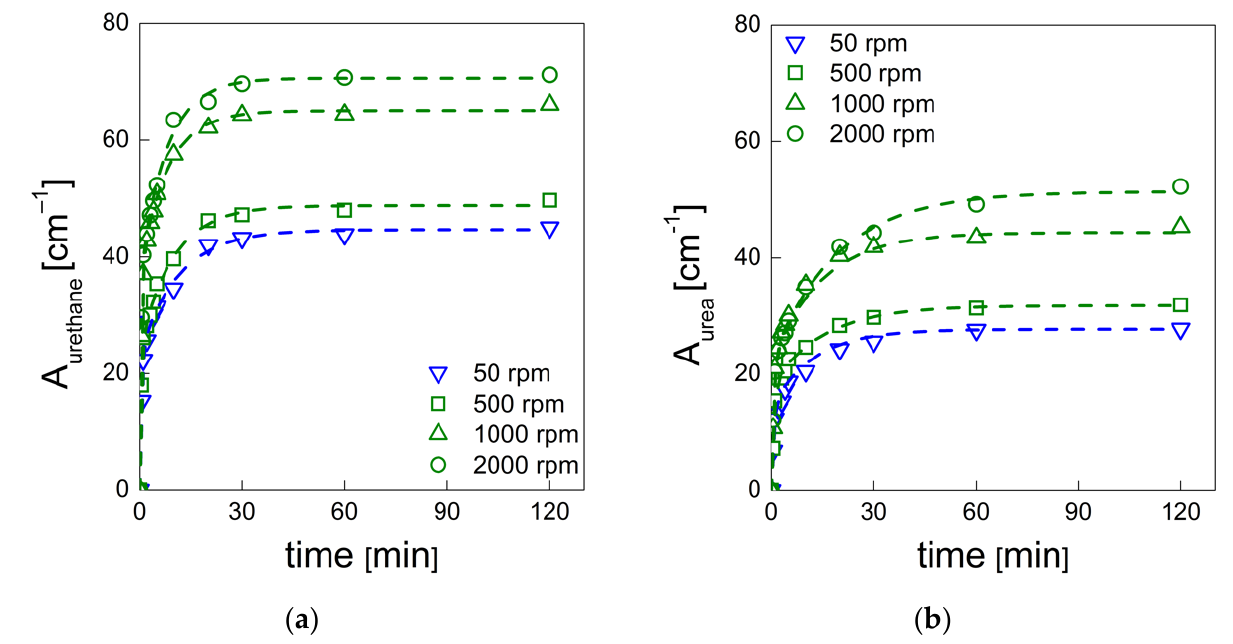
Figure 11. ( a ) Urethane and ( b ) urea formation obtained by deconvolution procedure as a function of time. Dots represent experimental data, dashed lines represent fitting of the experimental data by Equation (7). Table 7. Effect of mixing speed on urethane formation: results of the fitting procedure.